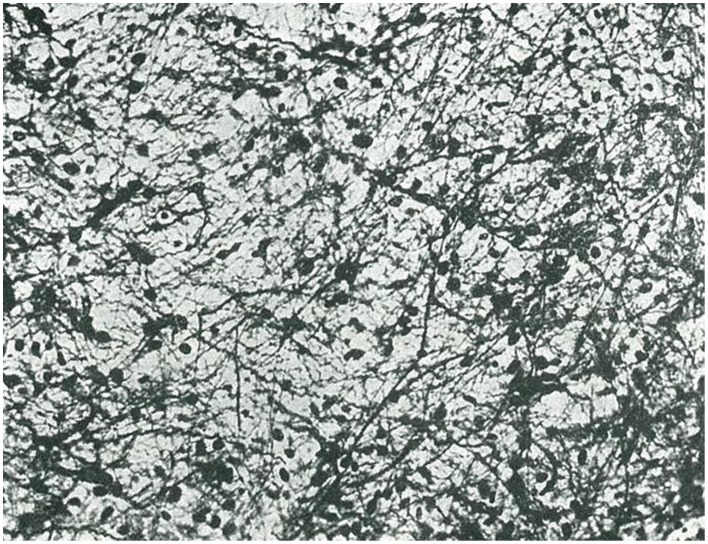
Example of fibrous astrocytoma (taken from Río-Hortega, 1933a).